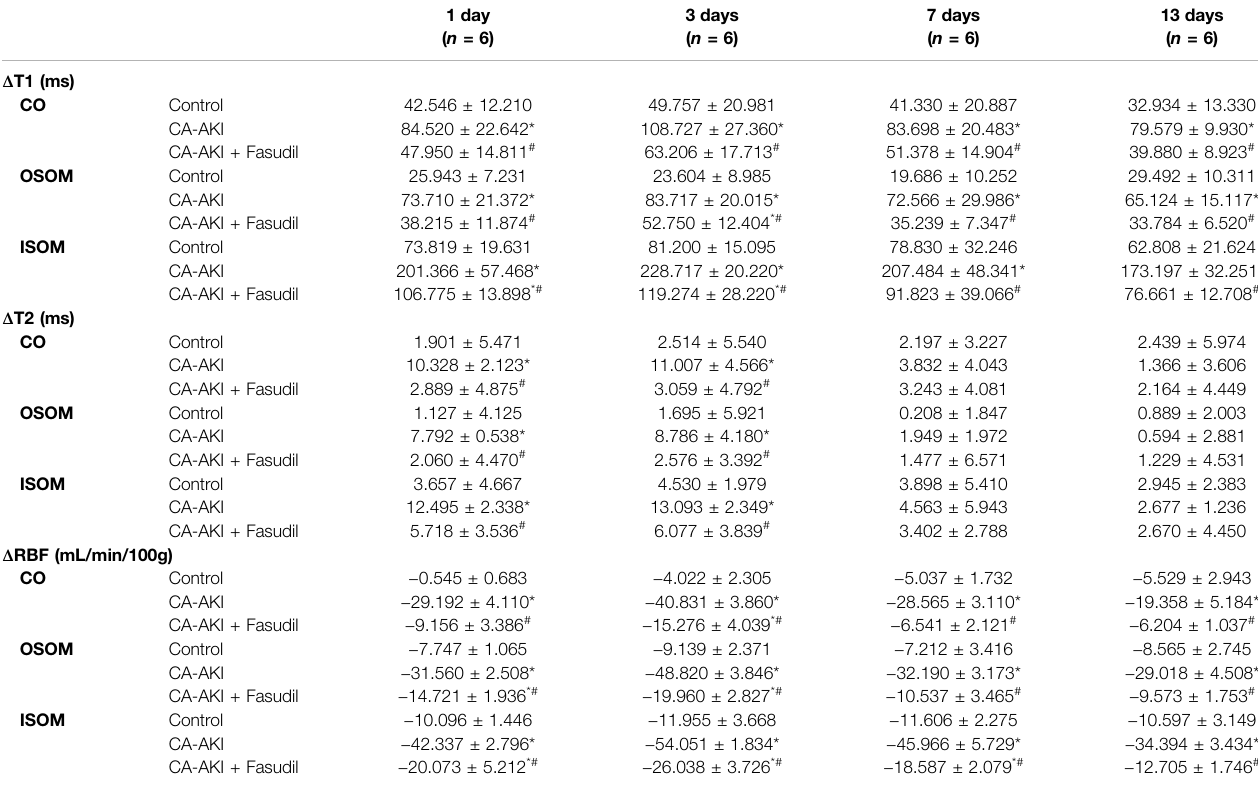
TABLE 2 | Overview of 13-day multiparametric zonal changes in kidneys for three animal